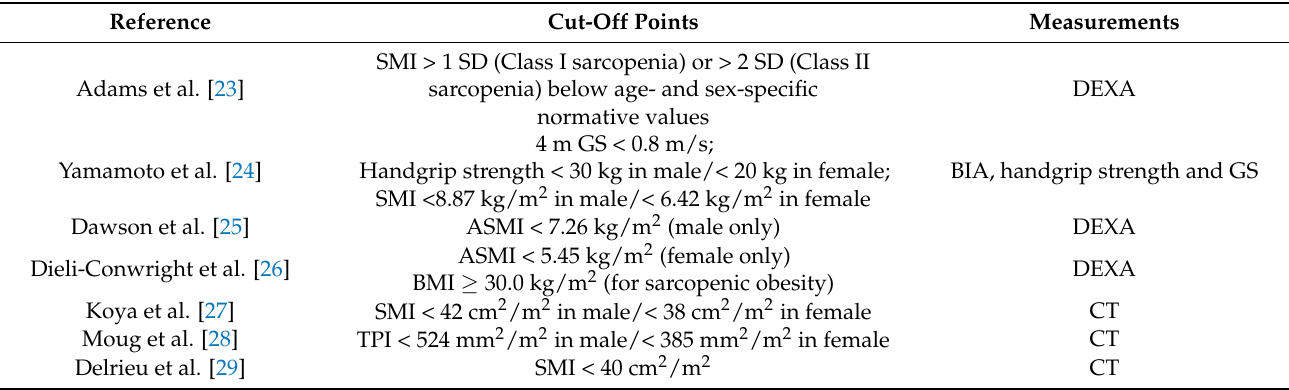
Table 1. Diagnostic criteria of sarcopenia a